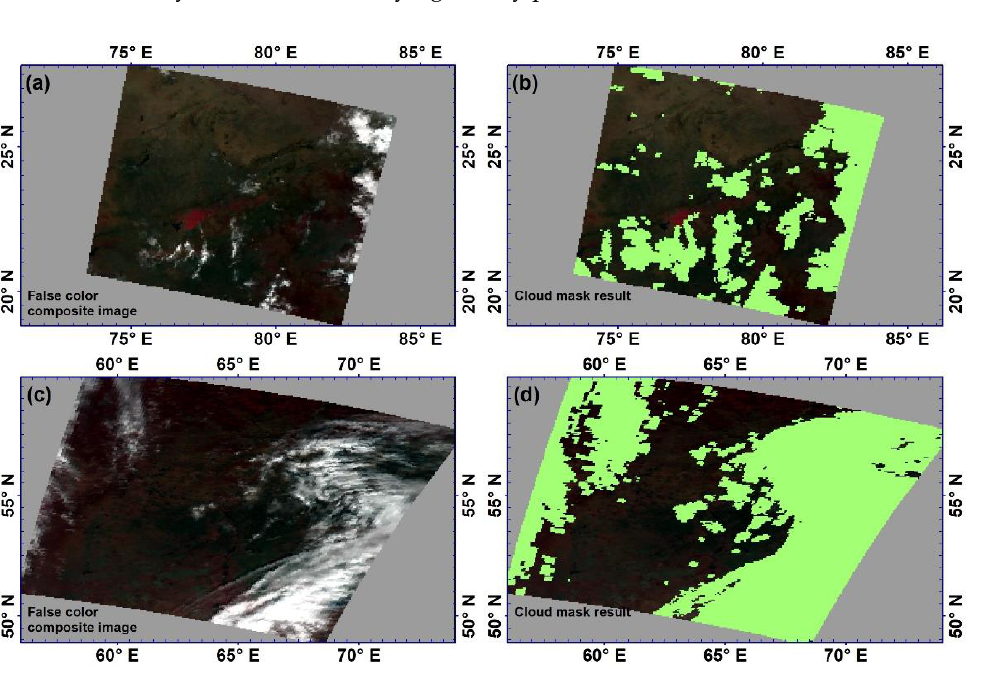
Figure 4. Examples of PSAC false color composite images and cloud mask results. ( a ) PSAC false color composite image of example 1. ( b ) PSAC cloud mask result of example 1. ( c ) PSAC false color composite image of example 2. ( d ) PSAC cloud mask result of example 2.